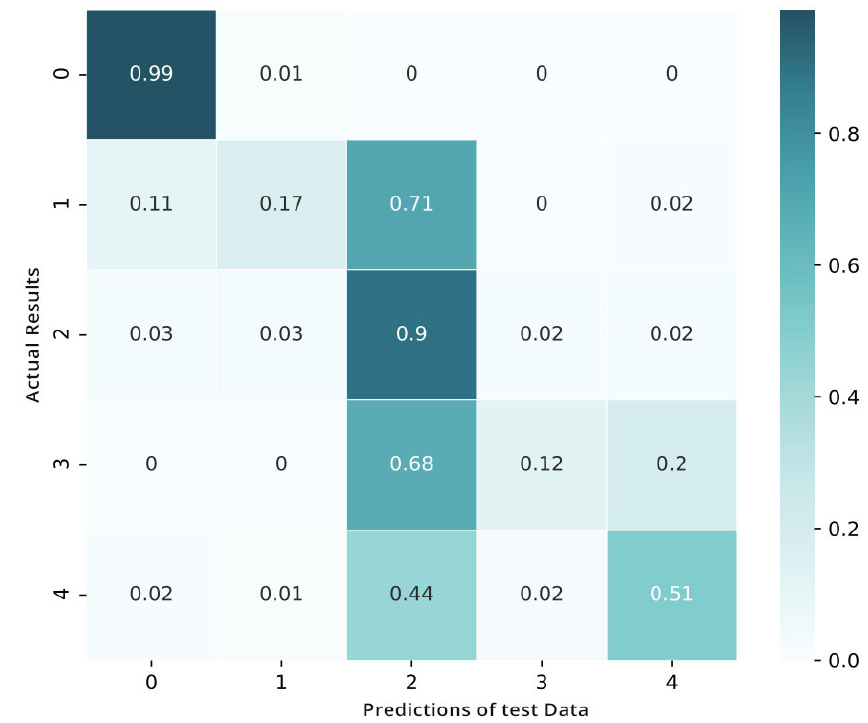
Figure 12. Confusion matrix after fine-tuning.